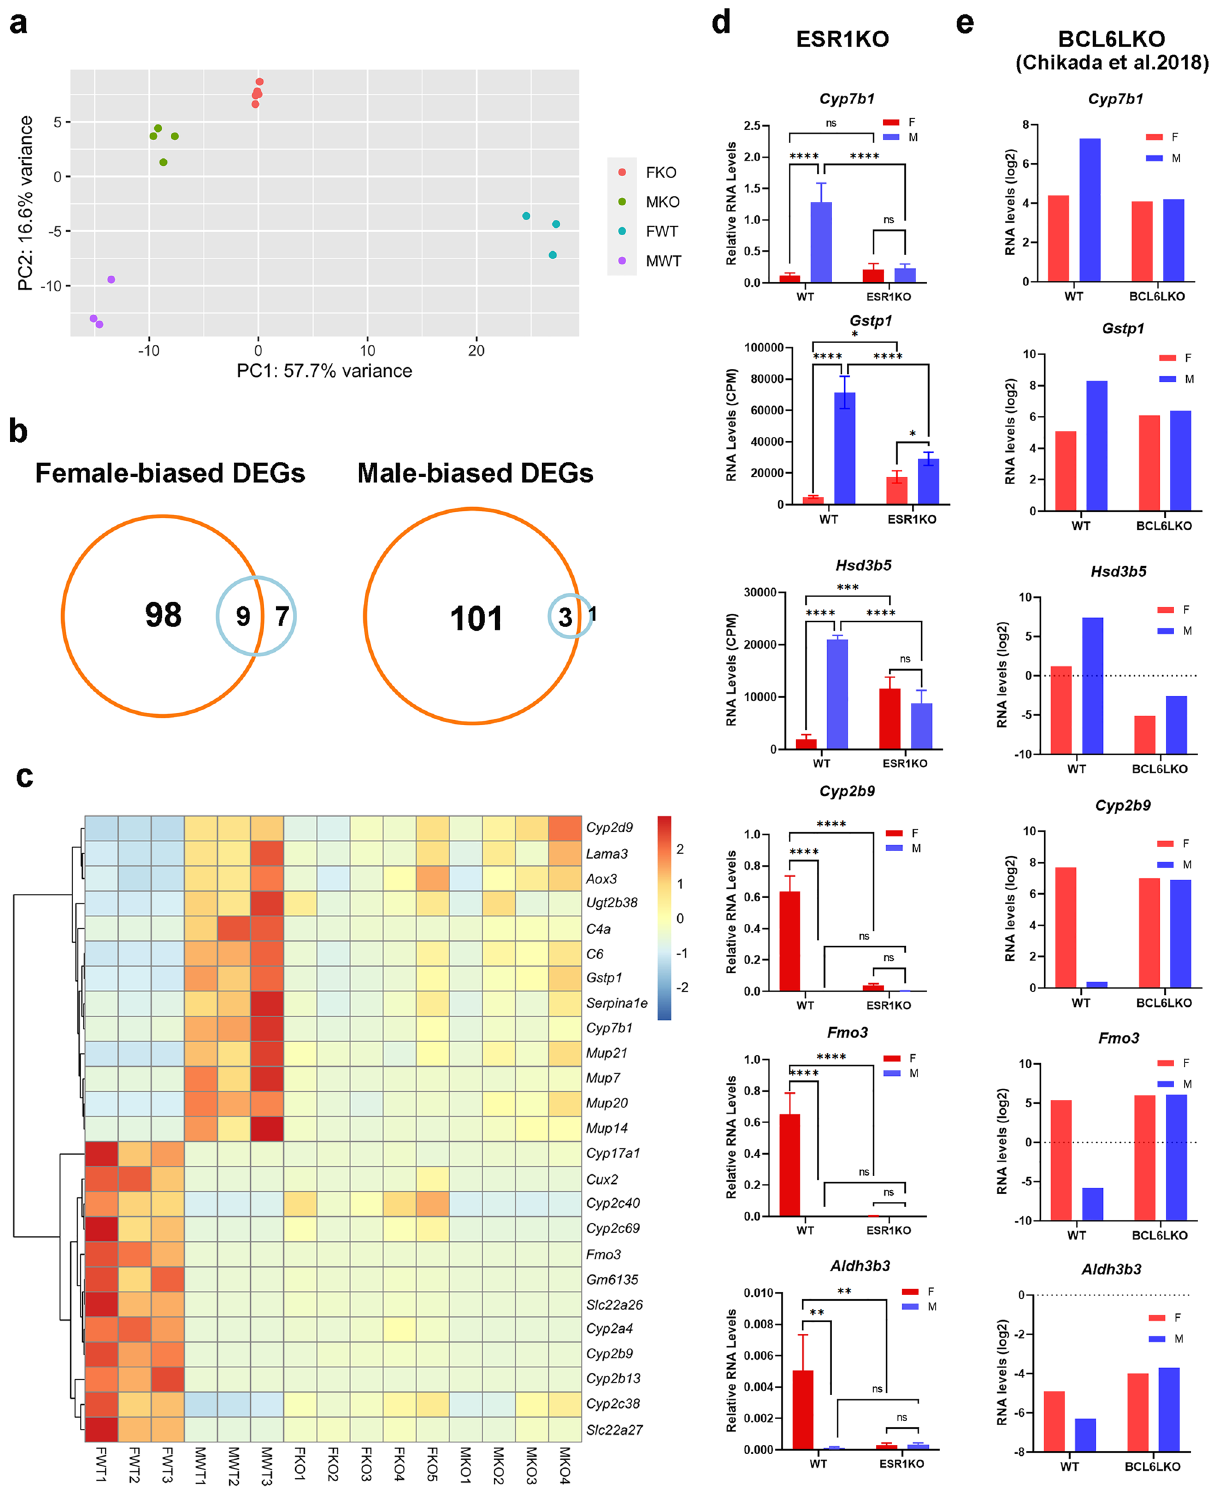
Figure 6. Ablation of ESR1 is associated with loss of sex bias in gene expression. ( a ) Principal component analysis (PCA) for RNA-seq data from ESR1KO and control mouse livers shows that samples cluster by genotype and sex, when comparing the first two principal components. ( b ) Overlapping DEGs between WT (orange) compared to the ESR1KO (blue): female-biased DEGs (left panel) and male-biased DEGs (right panel) are shown separately. ( c ) Heatmap shows the top 22 significant sDEGs as well as Cyp2b9, Cyp2b13 , and Fmo3 in WT and ESR1KO mice. ( d ) Relative expression levels of sDEGs in ESR1KO mice determined by RT-qPCR and normalized to Rpl19 (WT: 3 females and 3 males, ESR1KO: 4 females and 4 males) or retrieved from RNA-seq data ( Gstp1, Hsd3b5 ). Error bars show standard deviation. Statistically significant differences between sexes are shown with asterisks * P < 0.05, ** P < 0.01, *** P < 0.001, **** P < 0.0001, ns: non-significant (two-way ANOVA followed by multiple testing with Sidak’s correction). ( e ) Expression levels of sDEGs in Bcl6 -LKO mice (data from GSE89091 and GSE107435 displayed as log2 of normalized signal